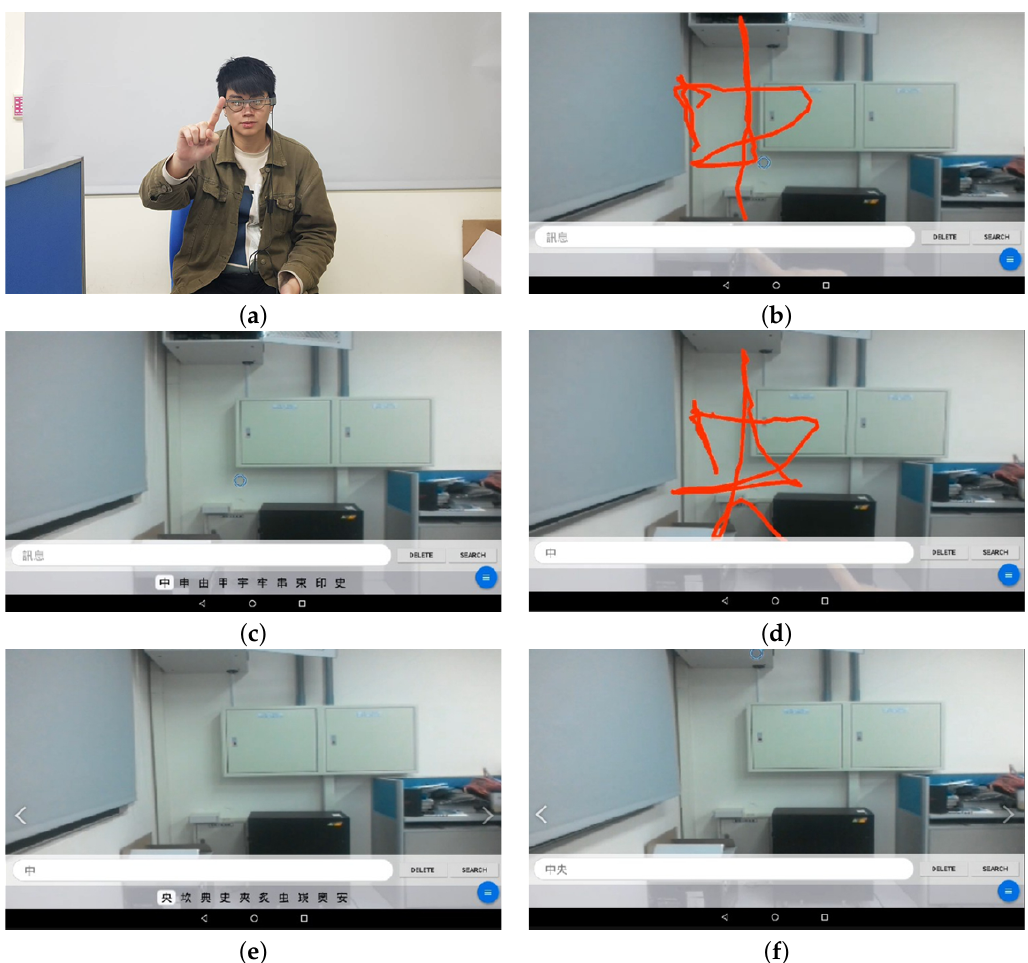
Figure 16. Example of air-writing for smart glasses: ( a ) a user wearing smart glasses writes characters in the air; ( b ) the writing trajectories of the first character; ( c ) the candidates are shown at the bottom of the the smart glasses screen; ( d ) the selected character is shown in the input text field and the user goes on writing the second character; ( e ) the candidates of the second character; and ( f ) the two characters are shown in the input text